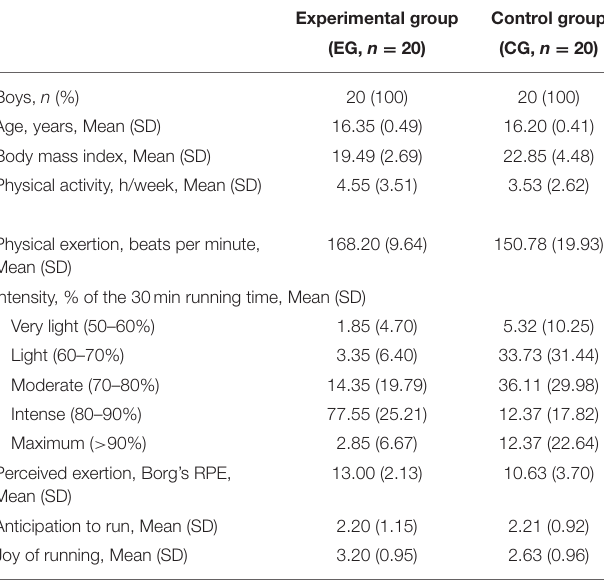
TABLE 1 | Demographic characteristics and descriptive statistics on raw data (means and standard deviation [in parentheses]) of physical and perceived exertion, anticipation to run, and joy of running of participants in the experimental and control